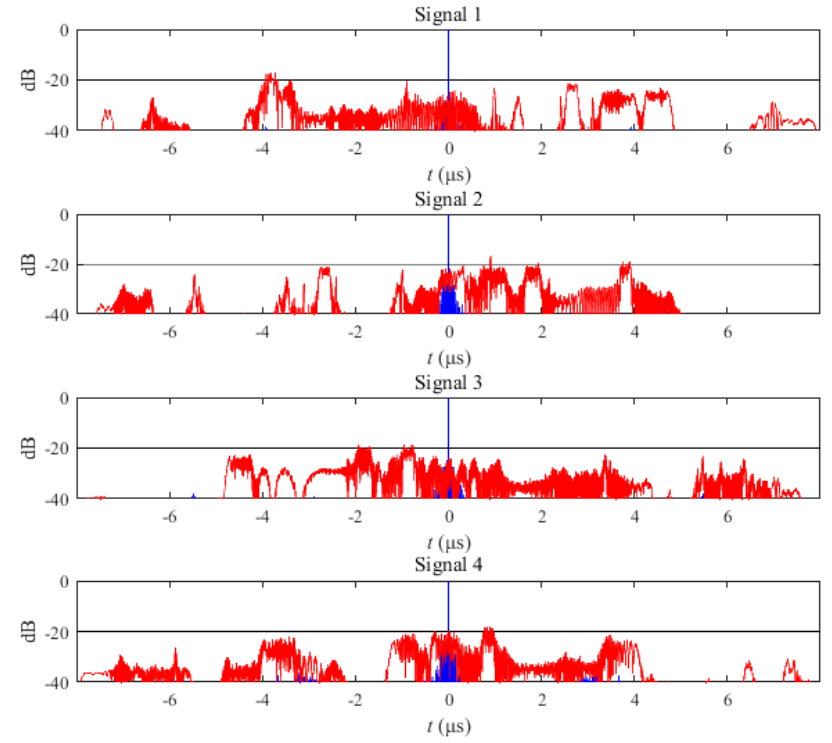
Figure 6. Auto-correlation function and cross-correlation function of the transmit signals of the IN-OFDM waveform set. Table 2. Sub-chirp rate PM code matrix of the optimal OFDM-NLFM waveform set.